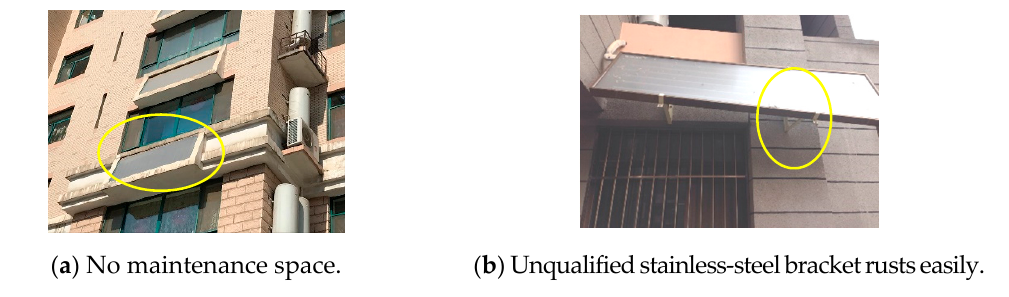
Figure 8. Common problems with wall-mounted installation.